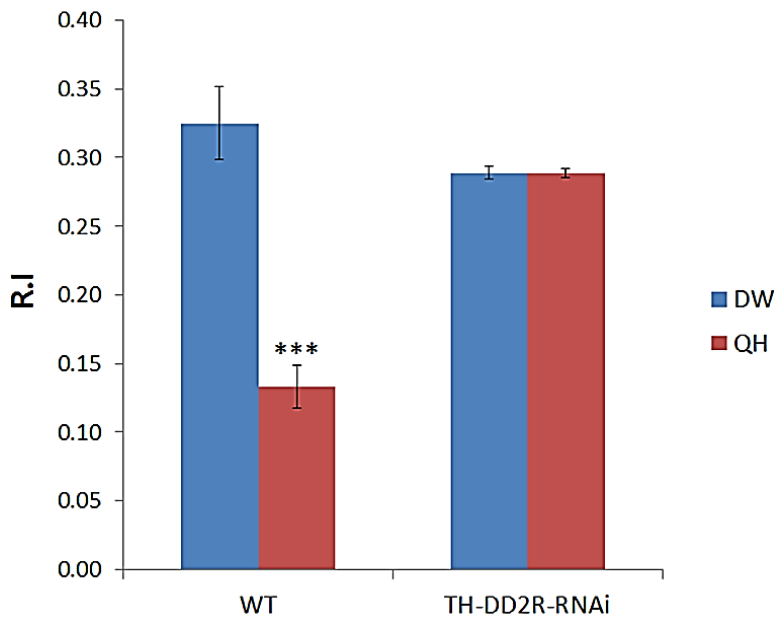
Figure 2. Expression of DD2R-RNAi in dopaminergic neuron-impaired aversive olfactory learning in Drosophila larvae. A dopaminergic (DA)-specific driver, TH-Gal4, was used to drive expression of DD2R-RNAi in DA neurons (TH-DD2R-RNAi). Number (n) of separate experiments: wild type (WT) with water (DW) or QH (3), TH-Gal4 × UAS-DD2R-RNAi (TH-DD2R-RNAi) with DW or with QH (10). Student t-test, *** p < 0.001.